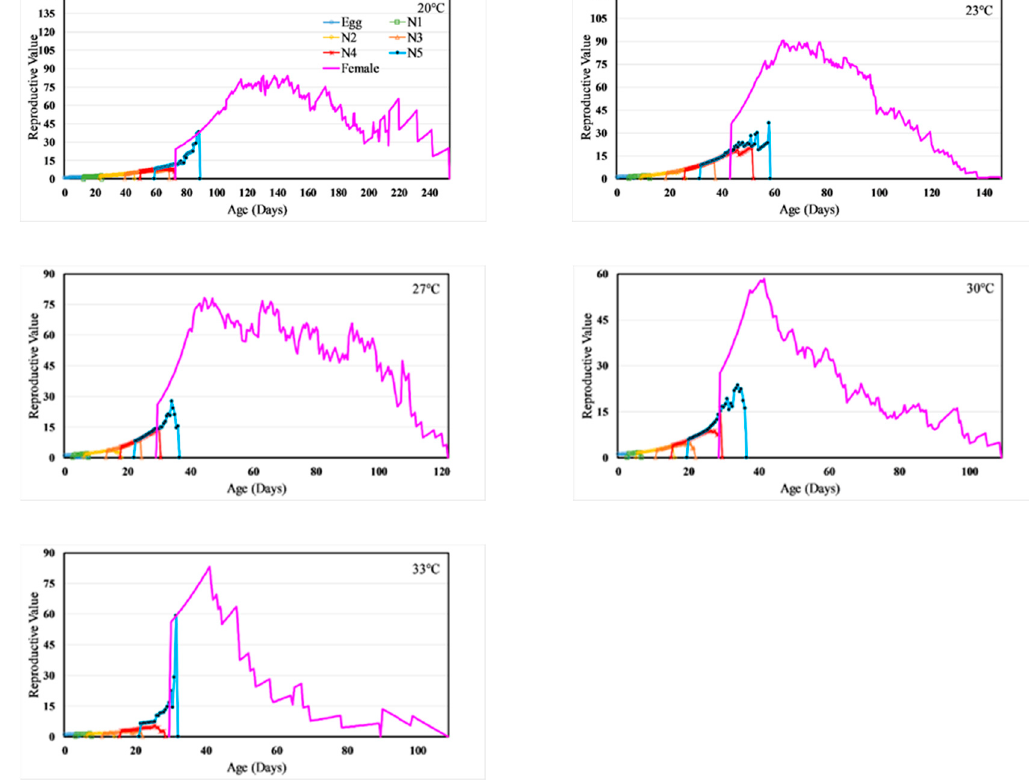
Figure 4. Temperature dependent age-stage-specific reproductive value ( v xj ) for H. halys.